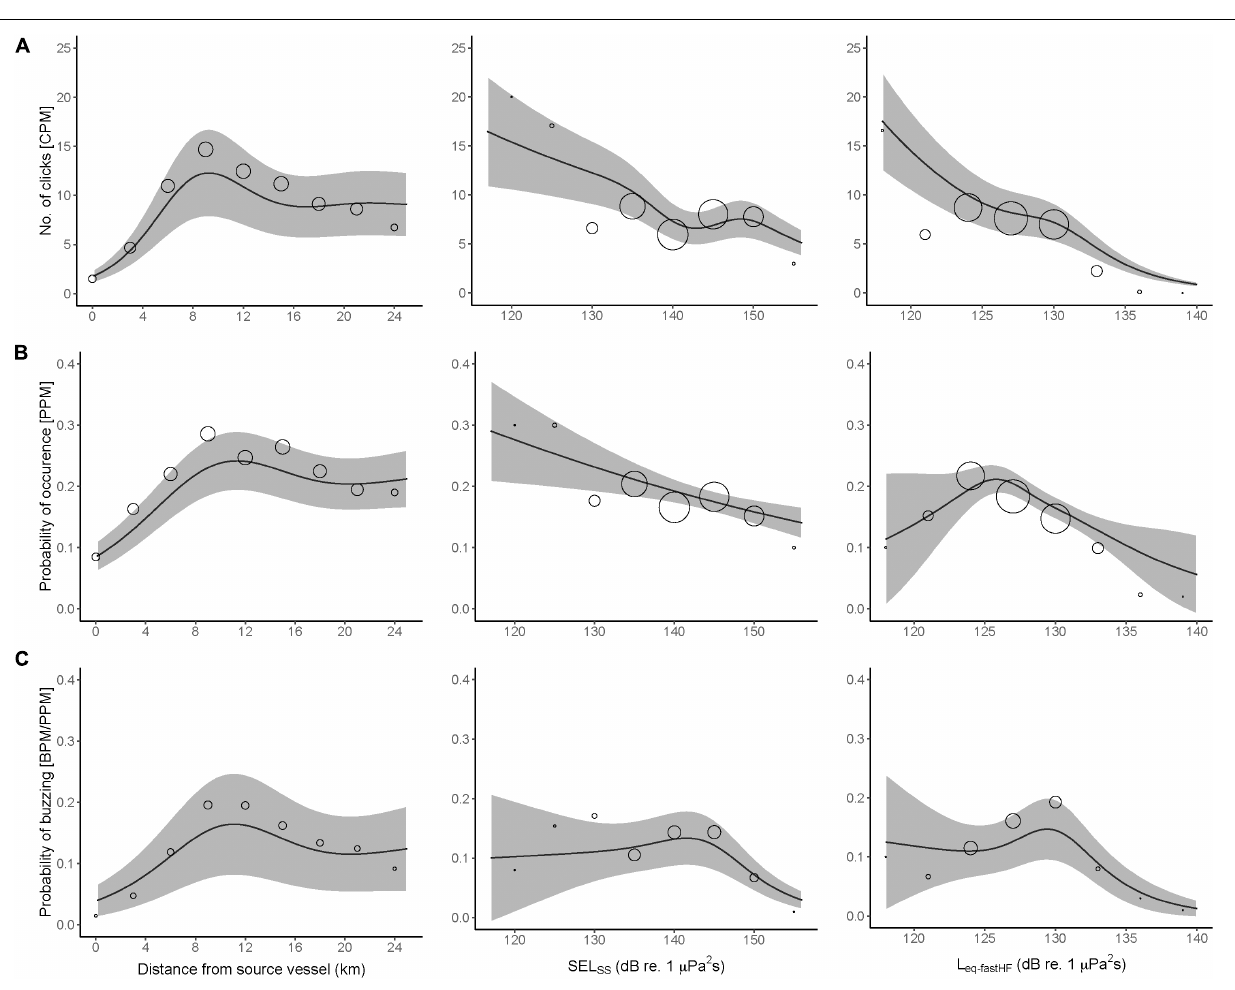
FIGURE 3 | (A) Predicted effect of distance to source vessel with an active airgun, left; SEL SS , center; L eq − fastHF , right. The number of porpoise clicks (CPM), (B) porpoise positive minutes (PPM), and (C) the probability of porpoise buzzing (BPM/PPM). Each panel is the result of a separate GAMM (see text for details). Circles indicate the modeled mean of CPM, PPM, and BPM/PPM for each model and 95% CI in gray shading. The size of the circles is proportional to the amount of data in each interval, i.e., the larger the circle the more precise the estimate